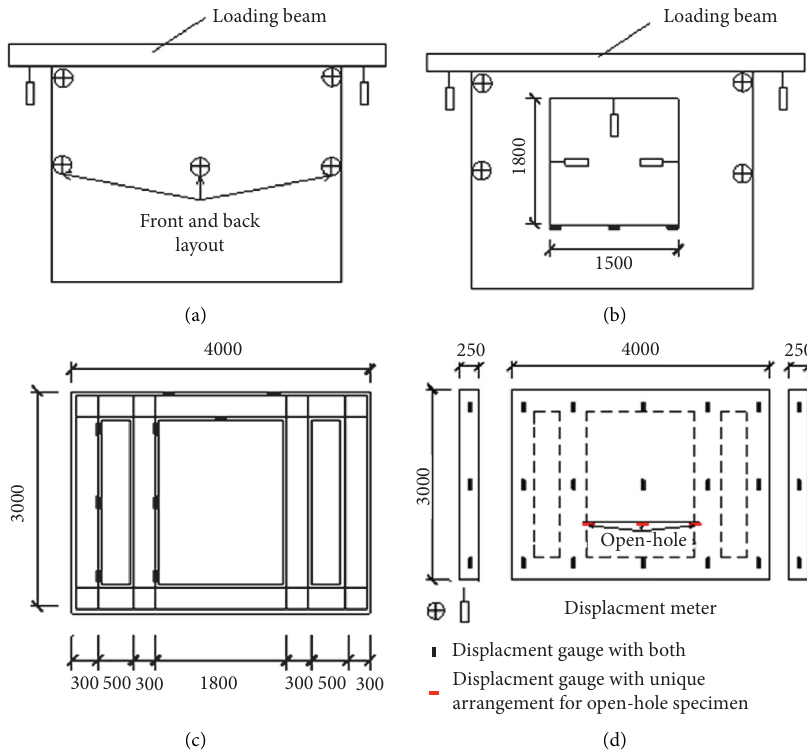
Figure 5: The arrangement of strain gauges and displacement meters (dimensions in mm): (a) displacement gauges layout of specimen without an opening hole; (b) the opening hole specimen displacement gauges; (c) layout of strain gauge measuring points for steel bars; (d) layout of concrete strain gauges for specimens with or without a hole. Table 2: Size and experimental results of the specimens. Rice husk content Group